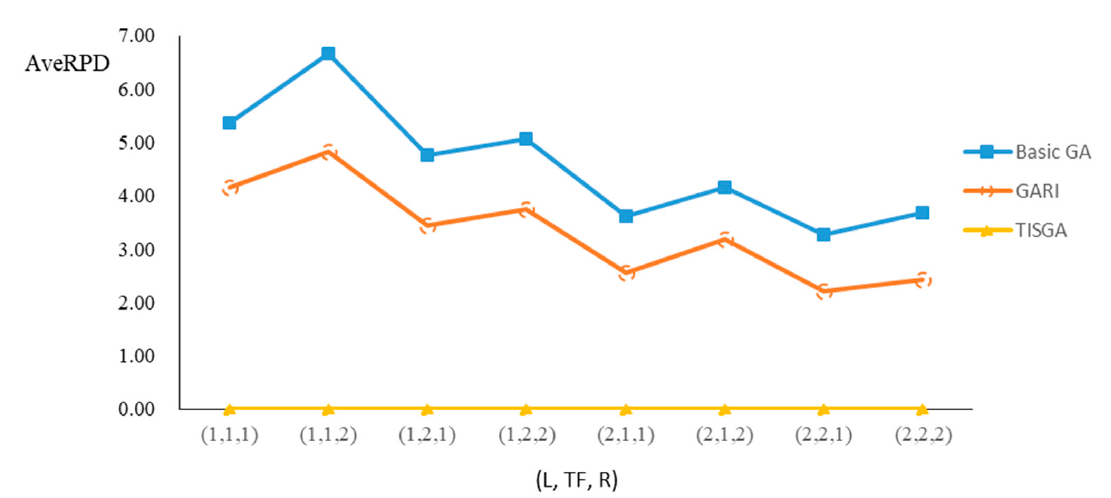
Figure 20. Comparison results for n = 200 with eight combinations of (L, TF, R).